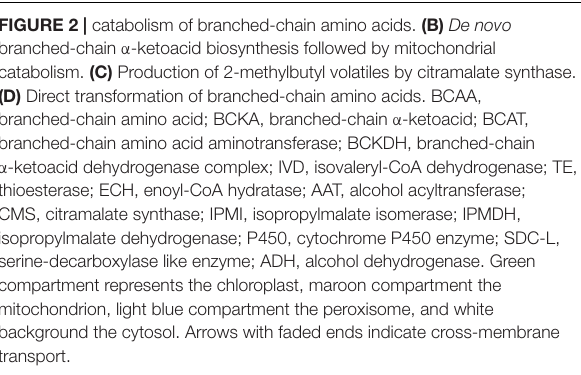
FIGURE 2 | catabolism of branched-chain amino acids. (B) De novo branched-chain α -ketoacid biosynthesis followed by mitochondrial catabolism. (C) Production of 2-methylbutyl volatiles by citramalate synthase. (D) Direct transformation of branched-chain amino acids. BCAA, branched-chain amino acid; BCKA, branched-chain α -ketoacid; BCAT, branched-chain amino acid aminotransferase; BCKDH, branched-chain α -ketoacid dehydrogenase complex; IVD, isovaleryl-CoA dehydrogenase; TE, thioesterase; ECH, enoyl-CoA hydratase; AAT, alcohol acyltransferase; CMS, citramalate synthase; IPMI, isopropylmalate isomerase; IPMDH, isopropylmalate dehydrogenase; P450, cytochrome P450 enzyme; SDC-L, serine-decarboxylase like enzyme; ADH, alcohol dehydrogenase. Green compartment represents the chloroplast, maroon compartment the mitochondrion, light blue compartment the peroxisome, and white background the cytosol. Arrows with faded ends indicate cross-membrane